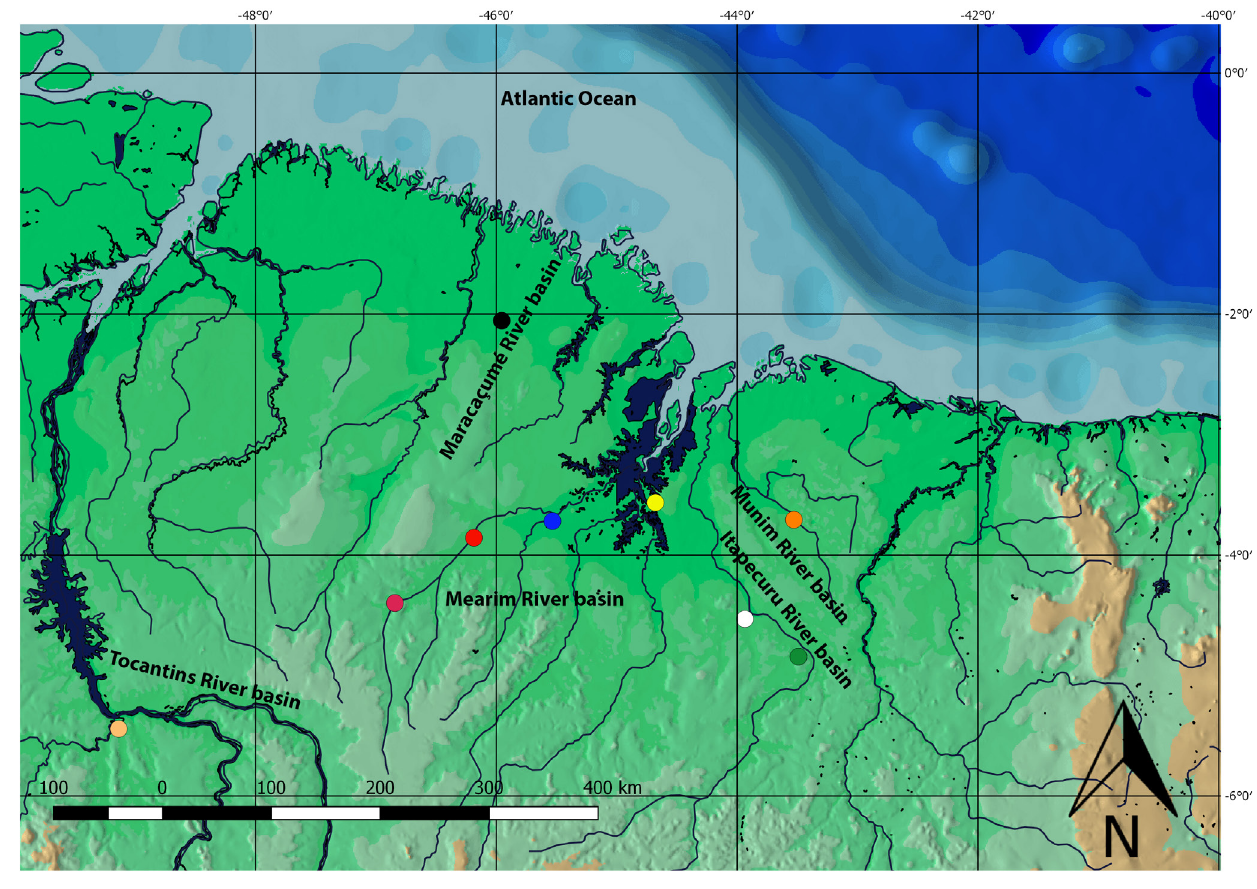
FIGURE 1 | Map of the sampling localities of Aphyocharax specimens in eastern Amazon coastal river drainages and surroundings in Brazil. Black circle = Aphyocharax brevicaudatus , Rio Maracaçumé/Maracaçumé/MA; orange circle = Aphyocharax sp. “Munim”, Riacho Fundo/Rio Munim/Chapadinha/MA; white circle = Aphyocharax sp. (Itapecuru), Riacho Primavera/Rio Itapecuru/Caxias/MA; green circle = Aphyocharax sp. (Itapecuru), Rio Saco/Rio Itapecuru/Codó/MA; yellow circle = Aphyocharax sp. (Mearim), Bacia 464/Rio Mearim/Arari/MA; blue circle = Aphyocharax sp. (Mearim), Rio Zutíua/Rio Pindaré/Rio Mearim/Pindaré-Mirim/MA; red circle = Aphyocharax sp. (Mearim), Rio Zutíua/Rio Pindaré/Rio Mearim/Pindaré-Mirim/MA; pink circle = Aphyocharax sp. (Mearim), Rio Pindaré/Rio Mearim/Bom Jesus das Selvas/ MA; salmon-pink circle = Aphyocharax avary , Rio Sororó/Rio